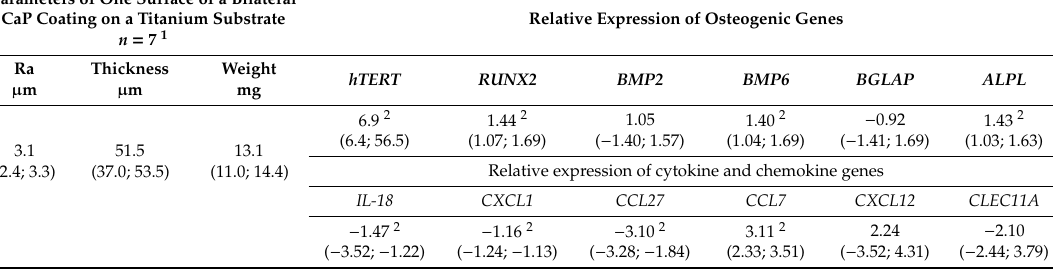
Figure 2. Correlations ( r > 0.75) between the technological coating properties and in vitro indices of hAMSCs cultured for 14 days with the microarc CaP-coated titanium substrates. Table 3. Relative gene expression levels (fold) in hAMSCs collected from plastic after 14 days of in vitro coculture with the microarc CaP-coated titanium substrates, Me (Q1; Q3).